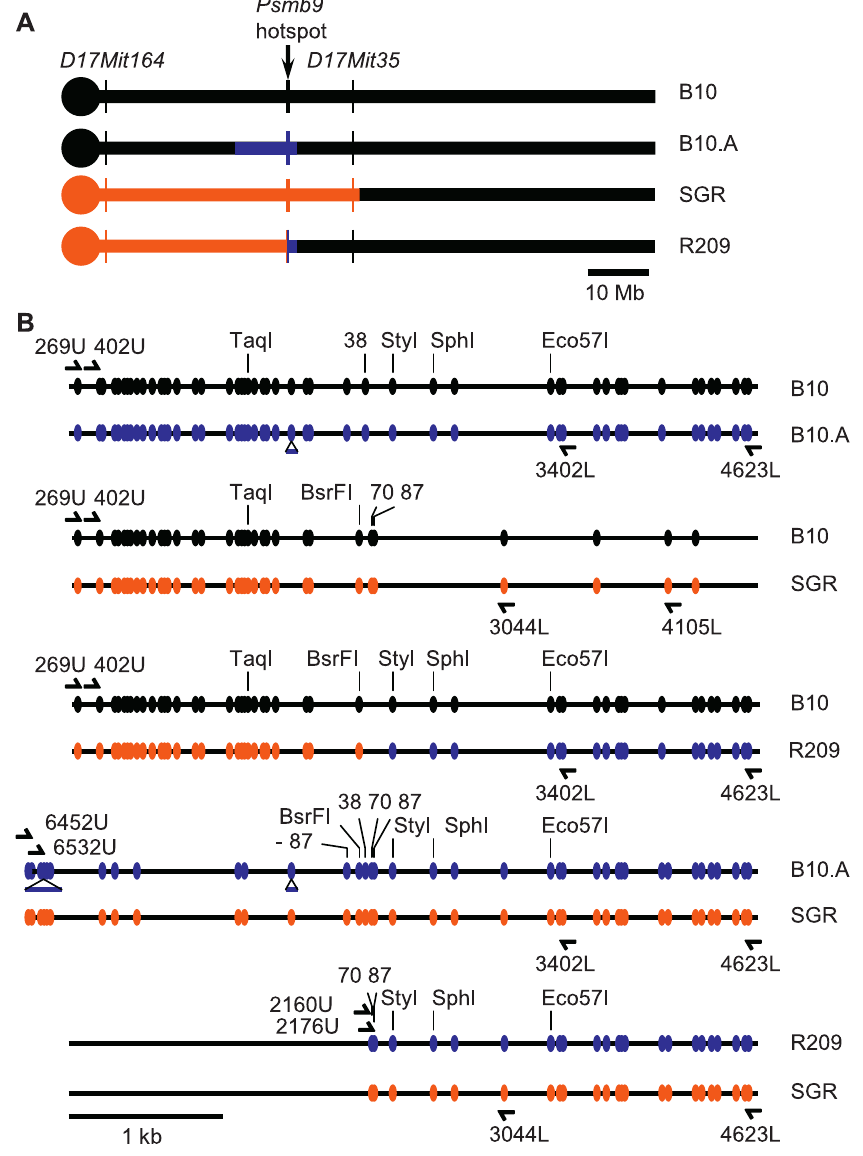
Figure 1. Maps of the Chromosome 17 and the Psmb9 Hotspot in the Different Strains (A) Origin of the Chromosome 17 fragments in the different parent lines is presented: black, B10; blue, A (haplotype a ); orange, SGR (haplotype wm7 ). (B) Map of the polymorphisms at the heterozygous state along the Psmb9 hotspot in the various hybrids is shown. The markers (cid:2) 87 , 38 , 70 , 87 , Sty I, and Sph I are 87 bp to the left, and 38, 70, 87, 213, and 474 bp to the right of the Bsr FI marker, respectively. doi:10.1371/journal.pgen.0030100.g001 (B10.A 3 SGR and B10 3 SGR), the CO frequency was about 4- fold lower in male than in female meiosis (Table 1).